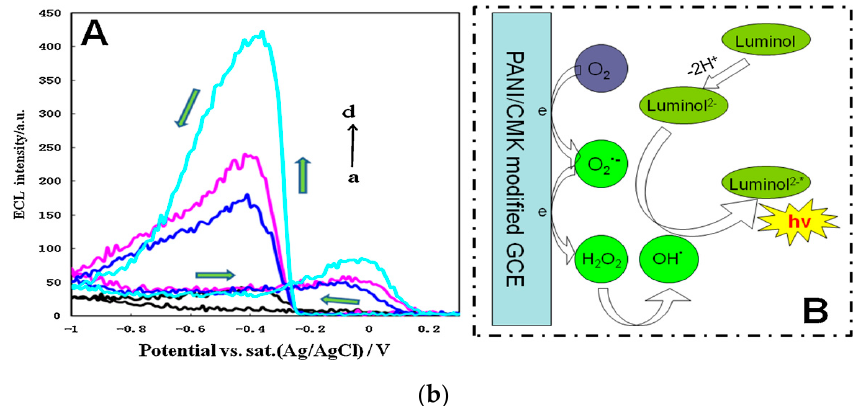
Figure 1. Application of OMC nanomaterials in the fabrication of sensors. ( a ) Assembly diagram of electrochemical aptasensor based on the OMC nanomaterials for Hg 2+ detection. Reproduced with permission from reference [61]. Copyright American Chemical Society, 2018; ( b ) modification of OMC nanomaterials to enhance the conductivity and stability of sensors. ( b - A ) The ECL behavior of luminol at PANI/CMK/GCE in PBS solution; ( b - B ) the process of luminol react with the ROSs. Reproduced with permission from reference [62]. Copyright Elsevier, 2012.